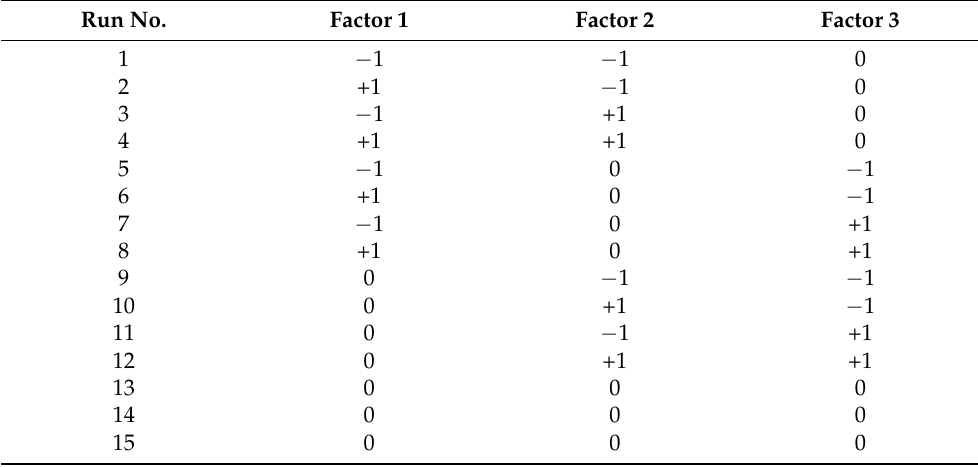
Table 1. Three-level factorial design in the Box–Behnken experimental plan. Run No.